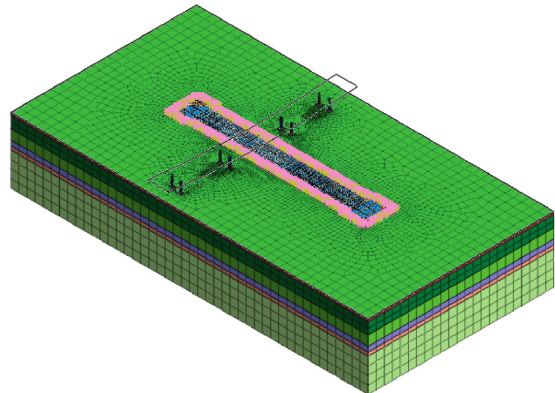
Figure 8: Three-dimensional geometric model.